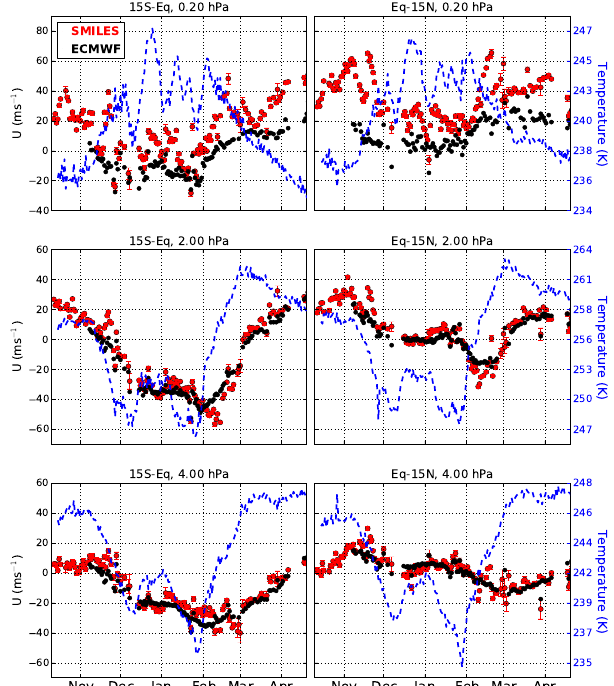
Fig. 13. Left panels: daily-averaged zonal-wind in the southern tropics (15 ◦ S–Eq) at 4, 2 and 0.2hPa ( ∼ 35, 41 and 60km) de- rived from SMILES measurements (red dots) and ECMWF analy- ses (black dots). Data are retrieved from the O 3 line in band-B or in band-A if B is not measured. Data with a line-of-sight orientation between ± 10 ◦ from the zonal direction are used. ECMWF winds are projected on the line-of-sight. The temperature profiles (blue dashed line) is a daily and zonal average of MLS measurements in the same latitudes range. Right panels: same as left panels but for the northern